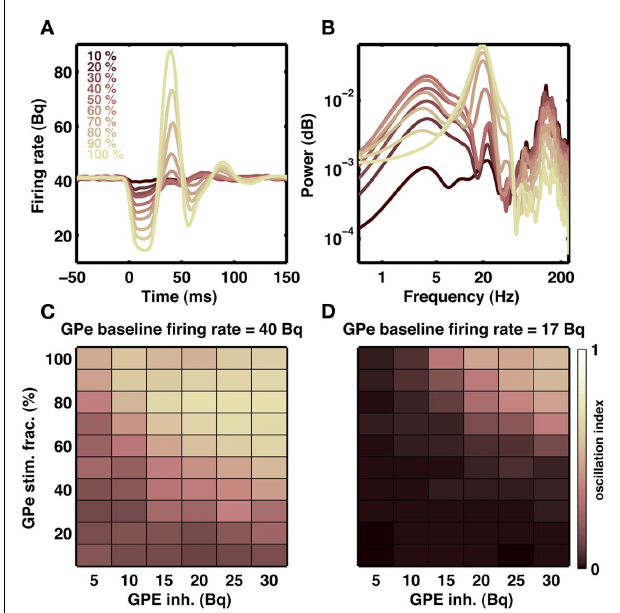
FIGURE 9 |Transient oscillation in STN-GPe loop. (A) Example of a transient (20ms) inhibitory input to a fraction of GPe neurons indicated by different colors. Each trace is an average of 20 stimulations.Transient inhibitory input induces a damped oscillation in the population activity of the GPe network. (B) Spectra of GPe activity shown in (A) .Transient inhibition of even 10% neurons generates a weak but visible oscillation at 20Hz. (C) Effect of strength of inhibitory input to the GPe ( x -axis) and fraction of GPe neurons inhibited ( y -axis) on the oscillation strength. (D) Same as in (C) , but with high baseline firing rate in the GPe network. Only when the baseline activity in the GPe is high transient inhibitory inputs to the GPe can initiate short lasting